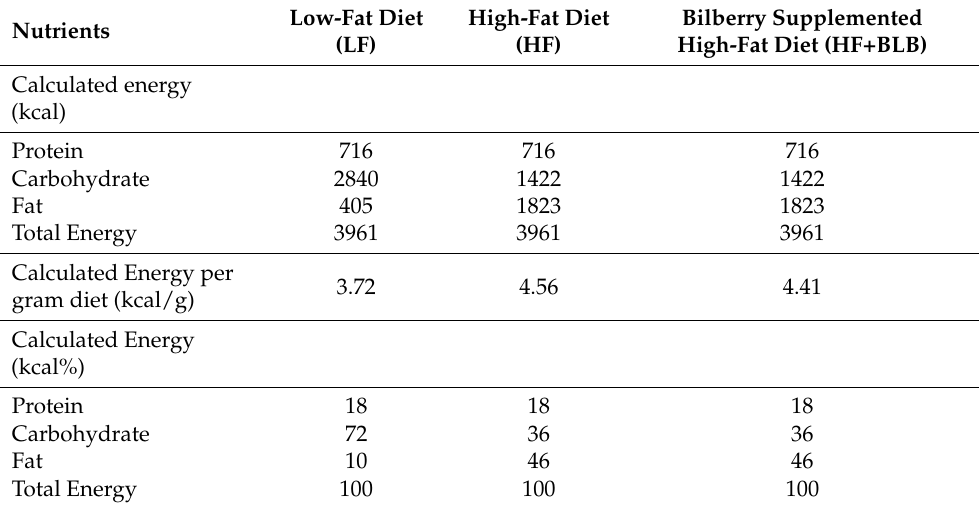
Table 4. Composition of the experimental